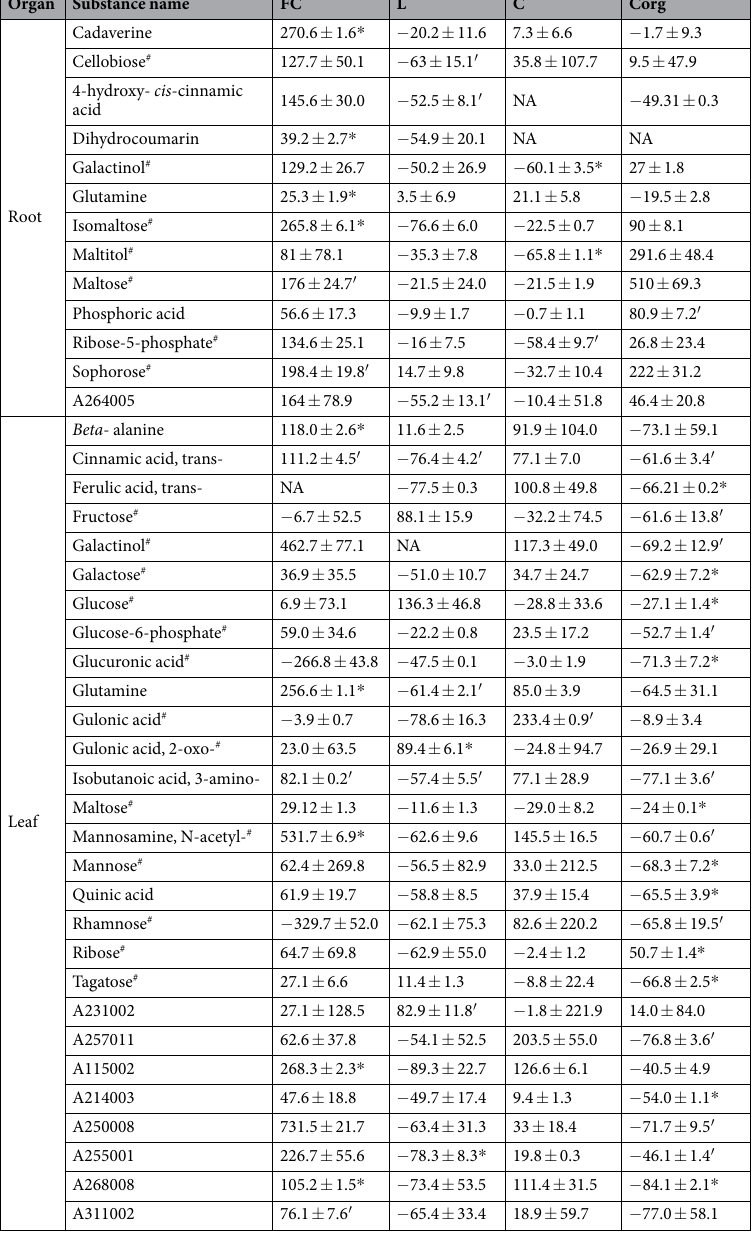
Table 3. Metabolite content changes in roots (A) or leaves (B) after seed inoculation by A . lipoferum CRT1. Ratios of mean content values of inoculated over mock-inoculated plantlets are listed and expressed as percentage values + / − percentage relative standard error. Wilcoxon non-parametric tests were conducted for each metabolite to compare inoculated and non-inoculated plants mean values for each field (FC, L, C and Corg). Only substances displaying significant content changes ( * p < 0.05; ′ p < 0.1) are listed. NA indicates that the metabolite was detected in less than 2 of technical replicate samples. Metabolites were identified by comparison with a standard and are listed in alphabetical order. Unidentified metabolites are named according to their code in the Golm Metabolome Database (http://gmd.mpimpgolm.mpg.de/). Carbohydrates and carbohydrate-related metabolites are marked with the pound sign ( #